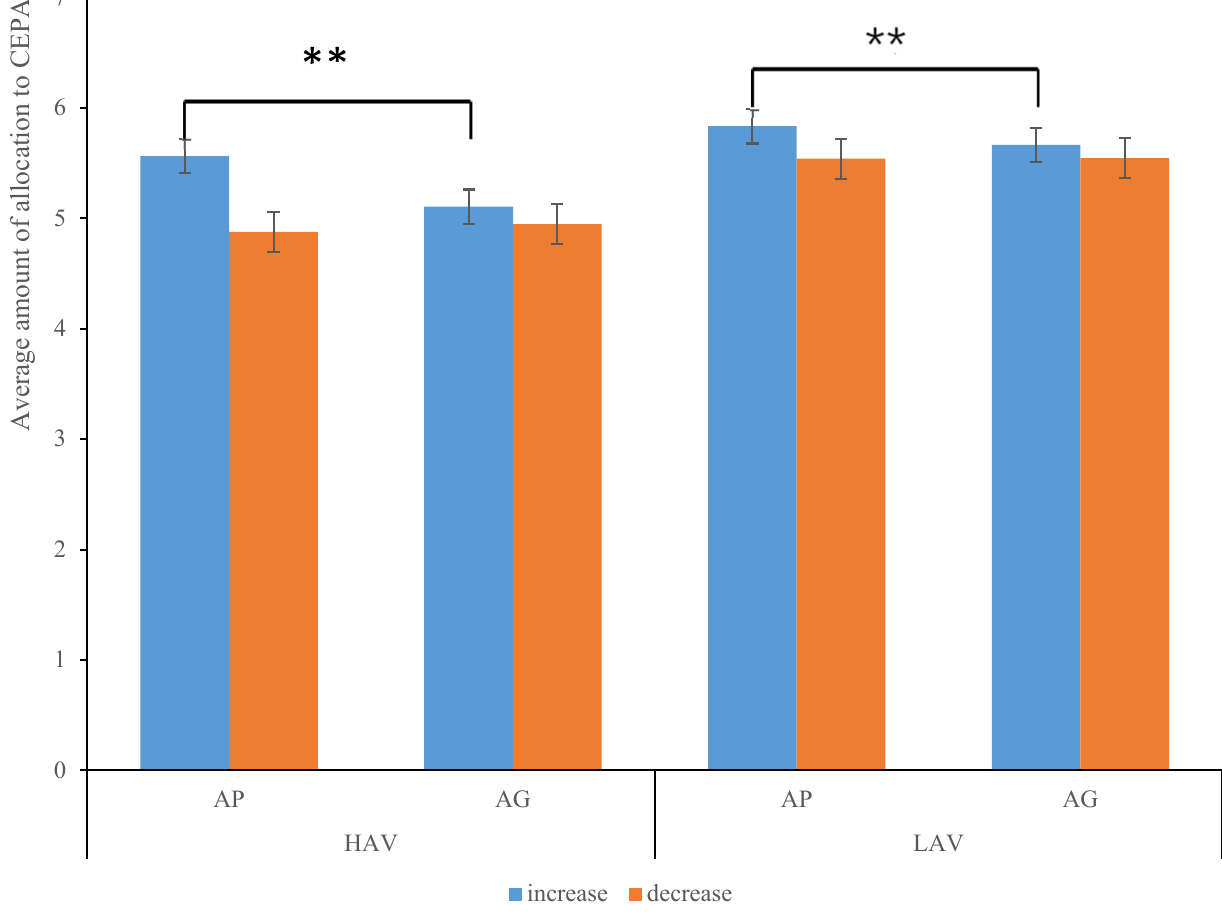
Figure 2. The descriptive statistics bar graph of the average allocation amount of aesthetic value environment. ** p < 0.01.